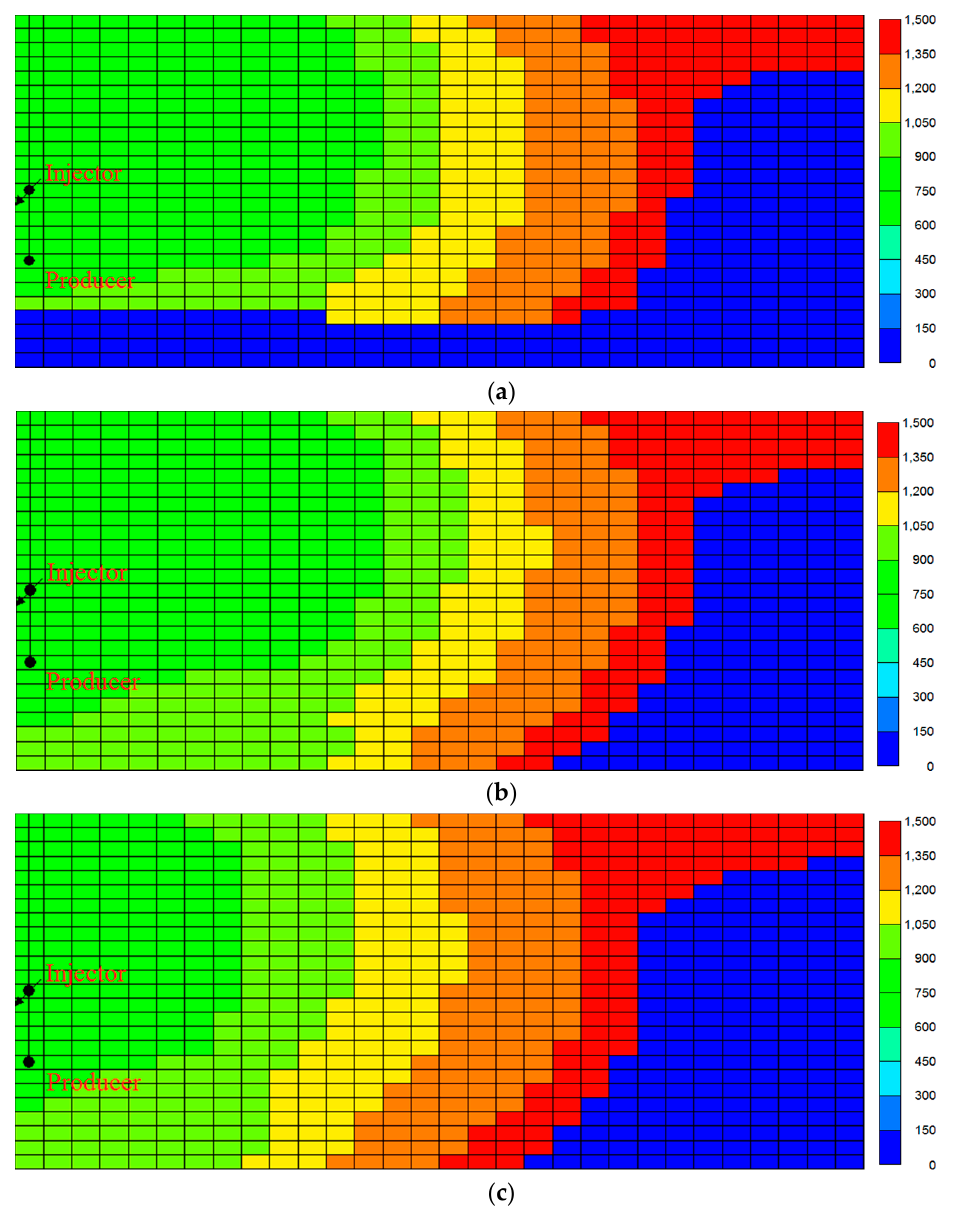
Figure 10. Mole density of the gas phase in the reservoir after 5 years of production: ( a ) no oil in the bottom water zone; ( b ) 10% oil saturation in the bottom water zone; and ( c ) 50% oil saturation in the bottom water zone.